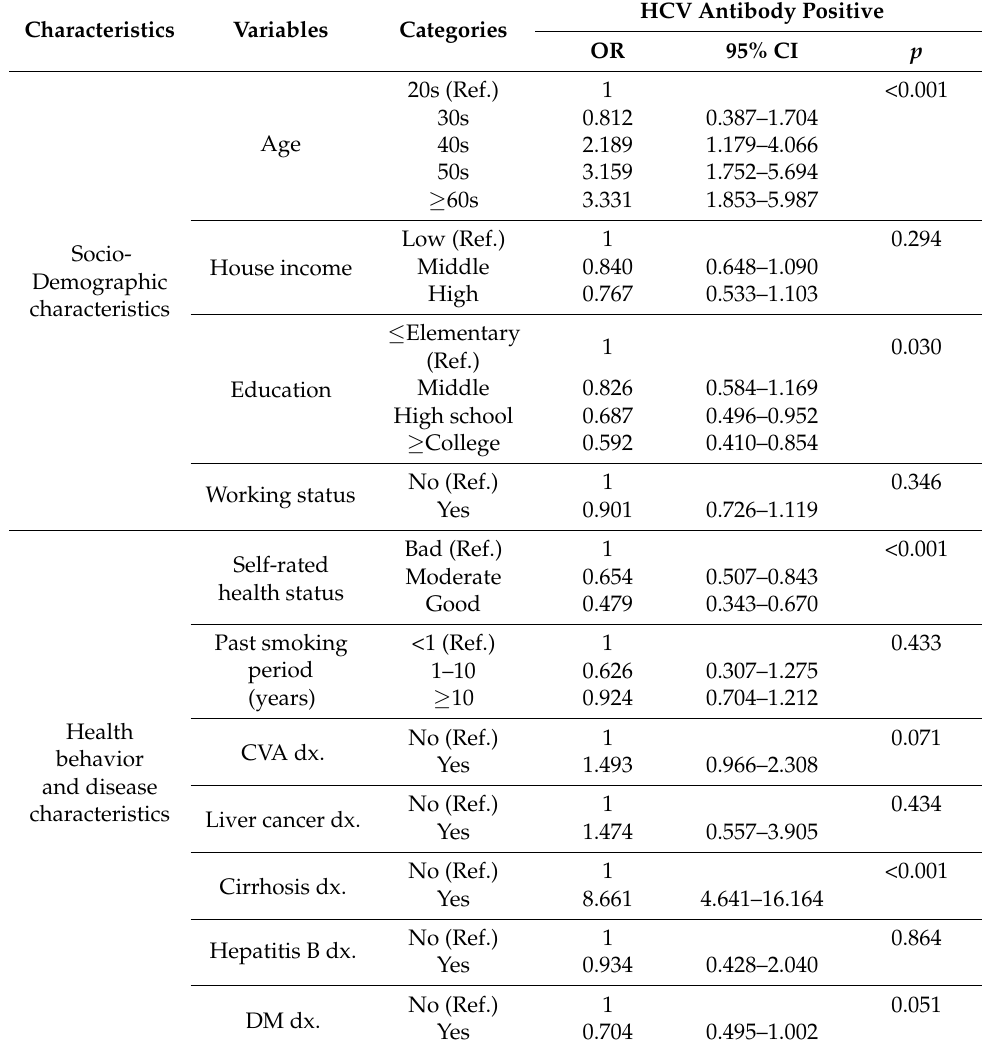
Table 3. Associated factors with positive HCV antibody status ( N =